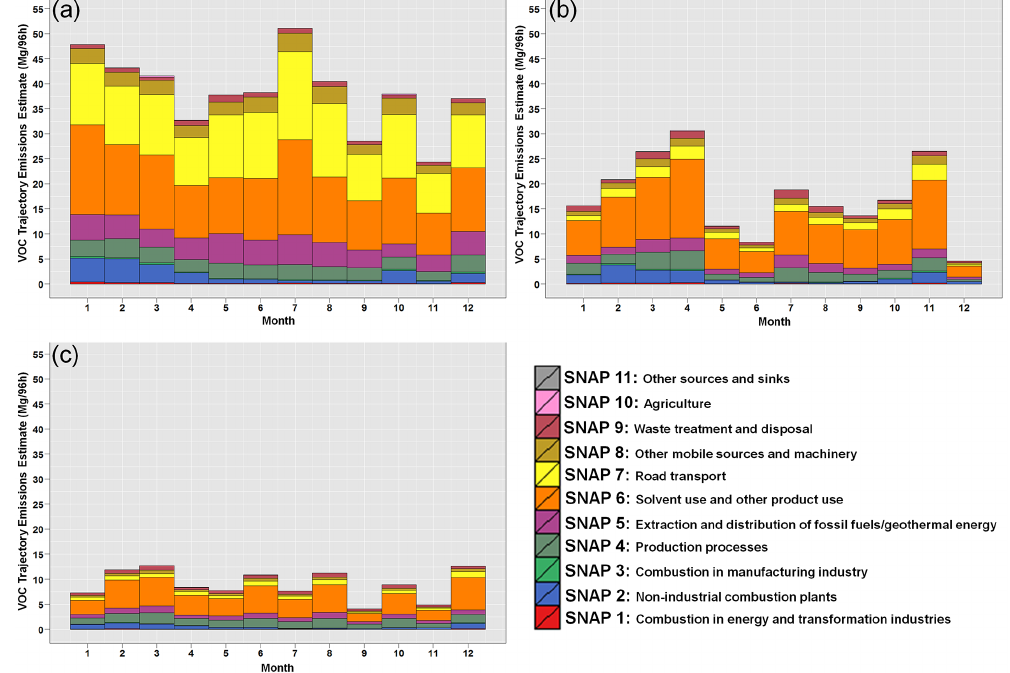
Figure 10. Monthly-average VOC 96h back-trajectory emission estimates prior to arrival at the receptor site, disaggregated into 11 SNAP source sectors for (a) Harwell 2001, (b) 2011 Harwell, and (c) Auchencorth